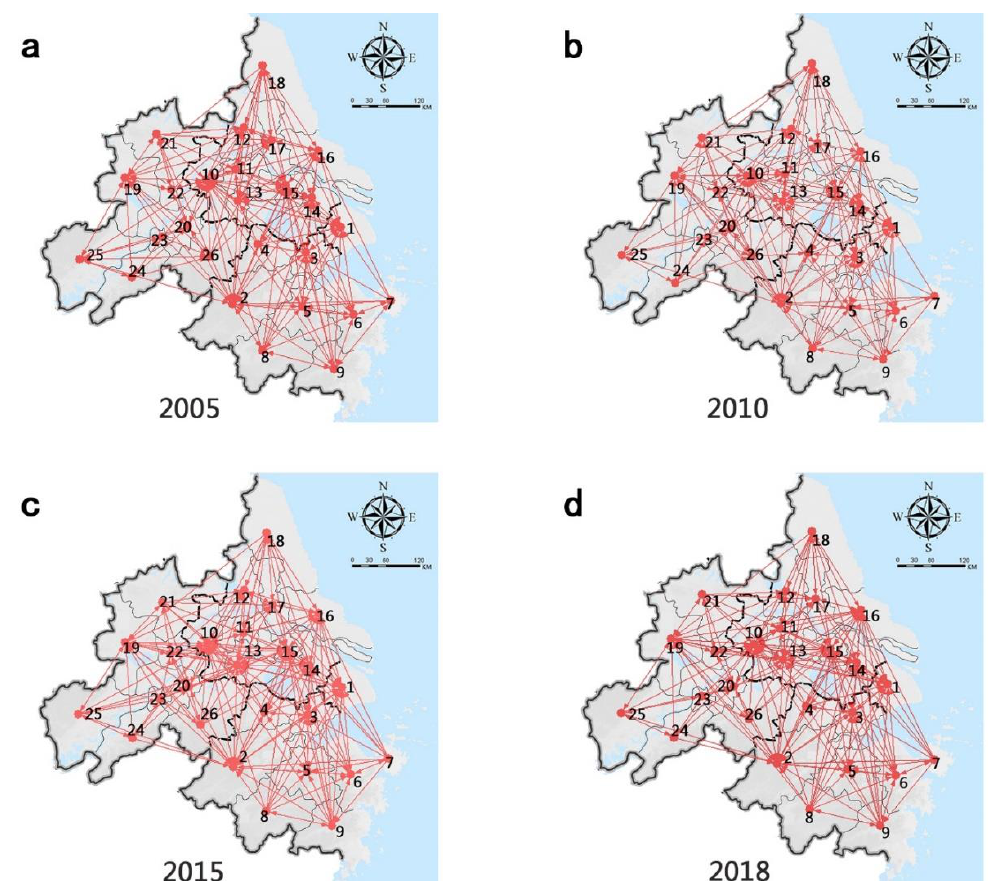
Figure 5. Spatial- association networks of CO2 emissions in the YRDUA’s cities : ( a ) in 2005; ( b ) in Figure 5. Spatial-association networks of CO 2 emissions in the YRDUA’s cities: ( a ) in 2005; ( b ) in 2010; ( c ) in 2015; ( d ) in 2018. 2010; ( c ) in 2015; ( d ) in